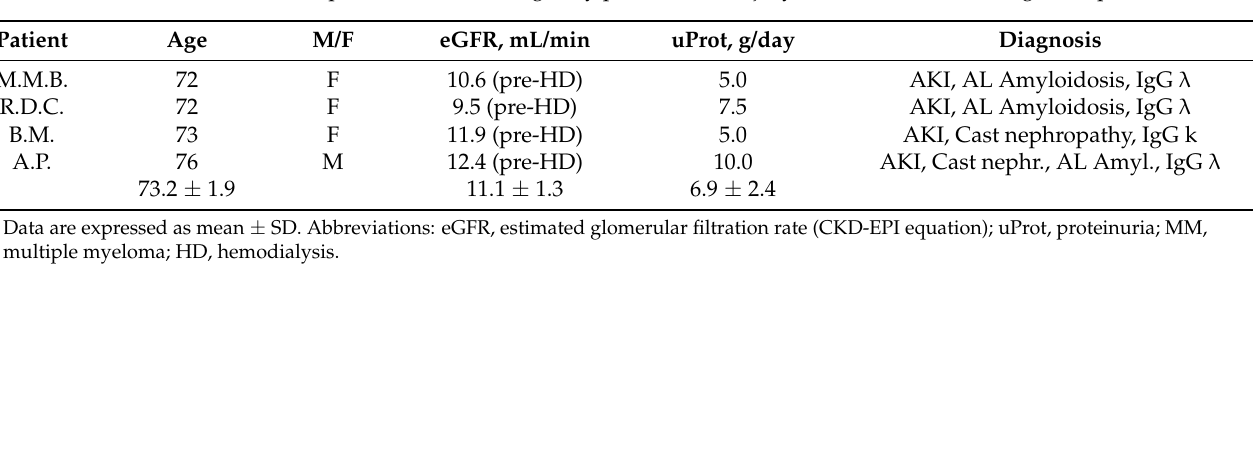
Table 1. AKI in 4 consecutive patients with histologically proven renal injury related to monoclonal gammopathies. Patient